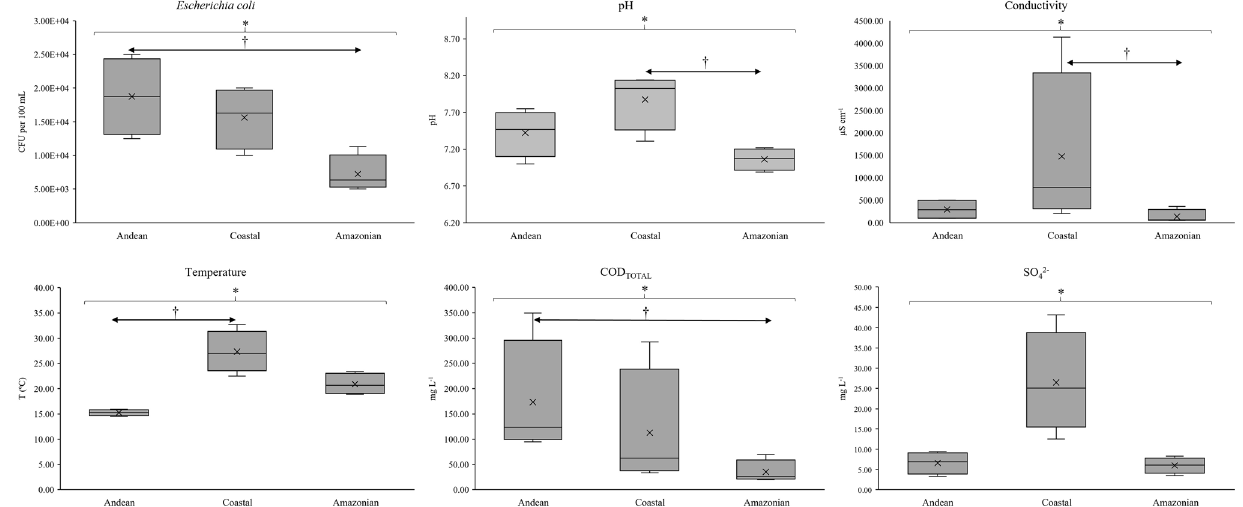
Figure 5. Statistical differences between regions (Andean, Coastal, and Amazonian) on microbial and physicochemical contamination in water samples of the present study. Legend: Statistical P -value obtained through Kruskal–Wallis non-parametric one-way analysis of variance ( P < 0.050); † Statistical P -value obtained through Mann–Whitney test for paired comparisons ( P <